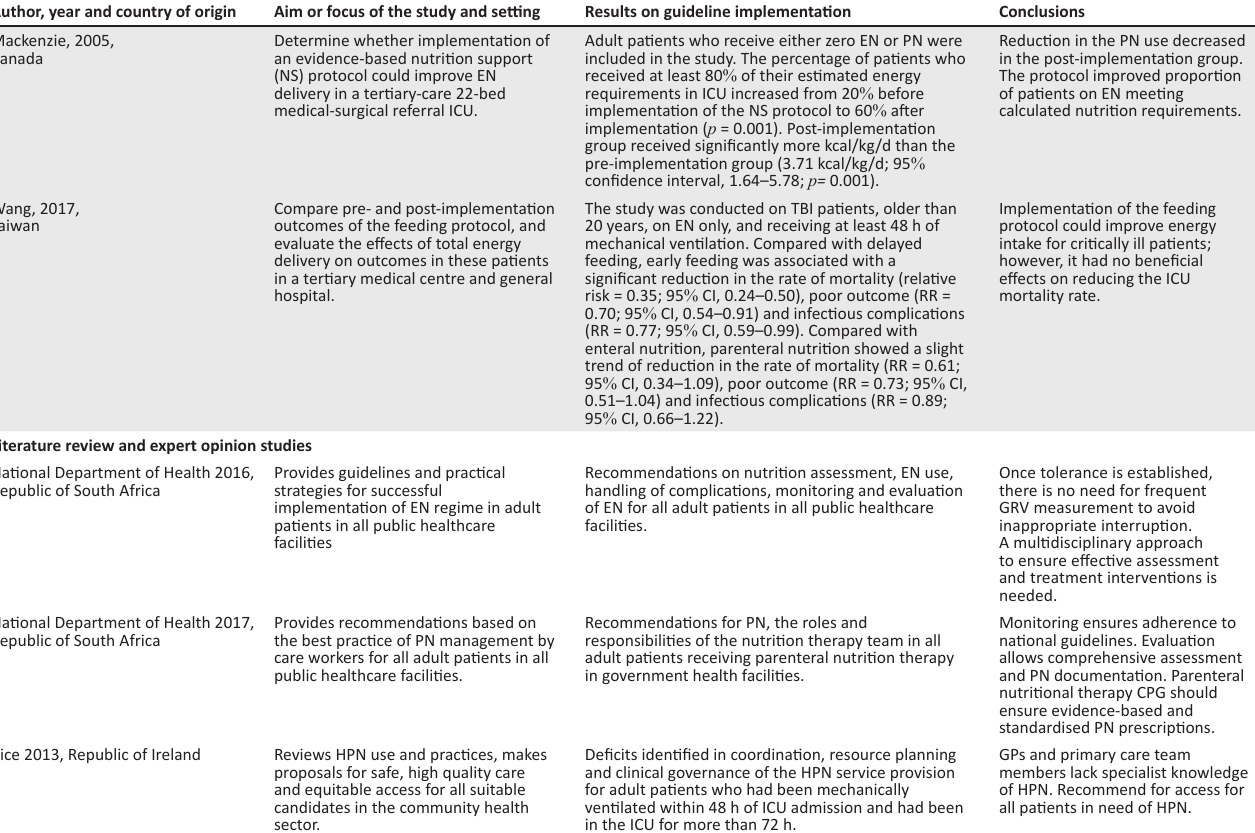
TABLE 6 (Continues...): Descriptive characteristics of the included